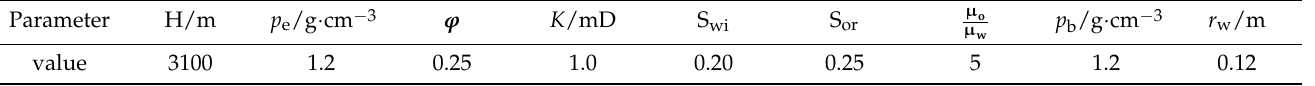
Table 1. Basic calculation data of the model.